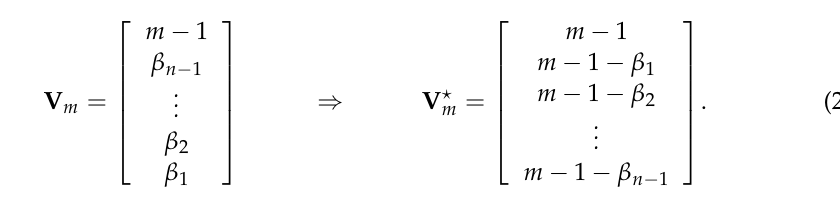
Figure 5. All the Configuration Voltage Vectors V m , in normalized form V m , for the case n = 3. Property 5. For every Configuration Voltage Vector V m , there exists a Conjugate Configuration Voltage Vector V (cid:63) , defined as m